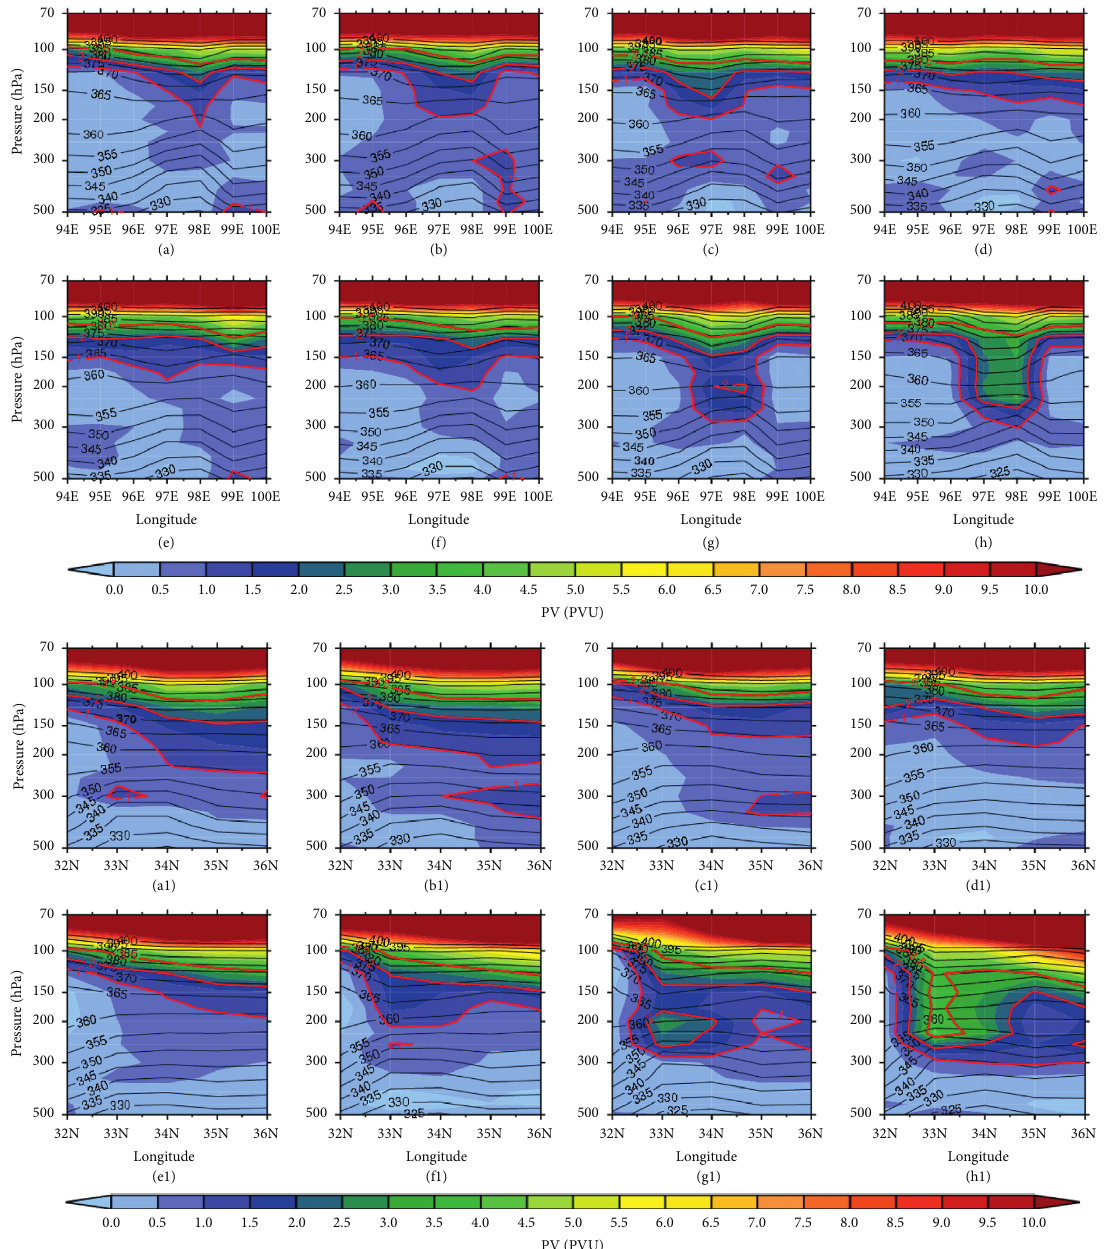
Figure 5: The composites of (a–h) longitude-pressure cross section at 34 ° N and (a1–h1) latitude-pressure cross section at 98 ° E of PV (units: PVU, color contours) and potential temperature (units: K, black lines, contour interval: 5K) fields for the (a, a1) 7th day, (b, b1) 6th day, (c, c1) 5th day, (d, d1) 4th day, (e, e1) 3rd day, (f, f1) 2nd day, (g, g1) 1st day, and (h, h1) 0 day before the OCS onset for 41 OCS events. The red lines show the contours of 1, 2, and 3.5 PV